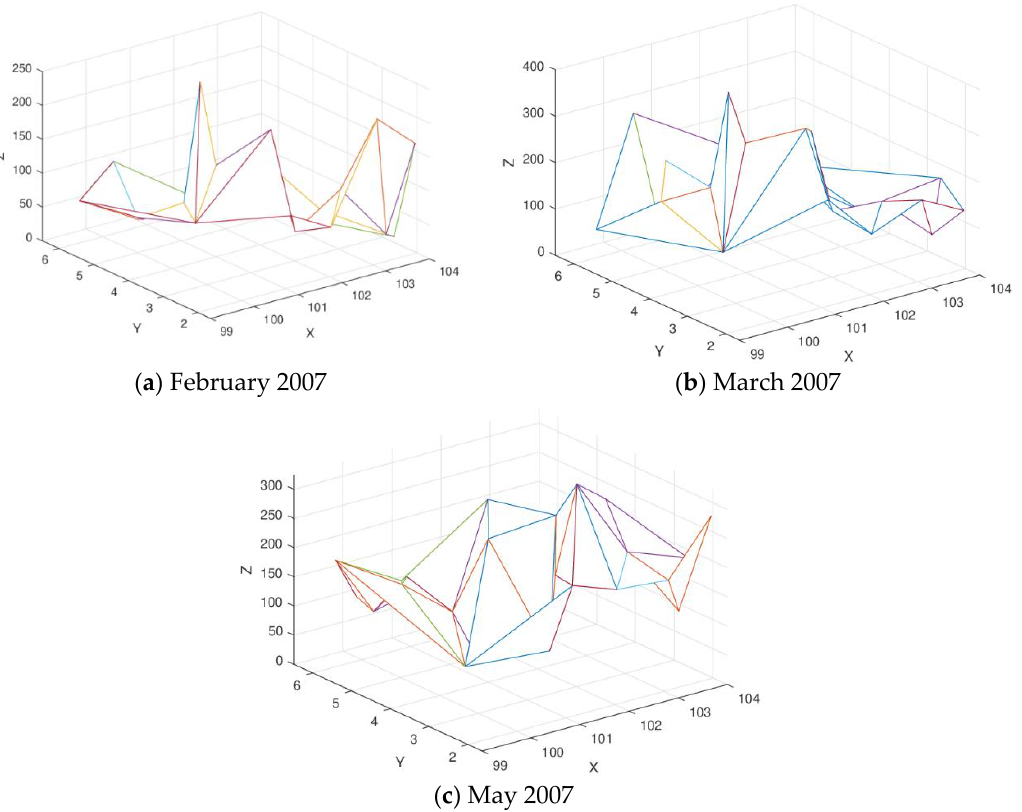
Figure 29. 3D Linear Interpolant of the rainfall data.